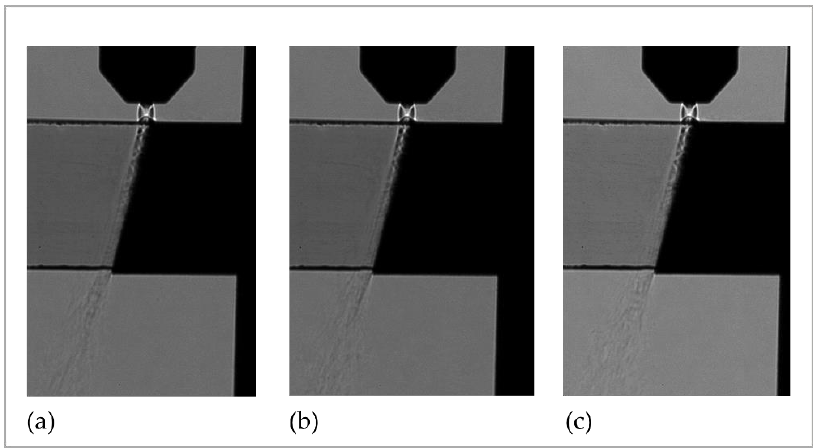
Figure 4. Schlieren images of gas flow inside fabricated cut kerf captured during three different experiments using same process parameters (nozzle exit diameter ( φ exit ) = 2mm; inlet gauge pressure (P) = 6 Atm). ( a ) Experiment 1 (t = 493 ms), ( b ) Experiment 2 (t = 686 ms), and ( c ) Experiment 3 (t = 889 ms).